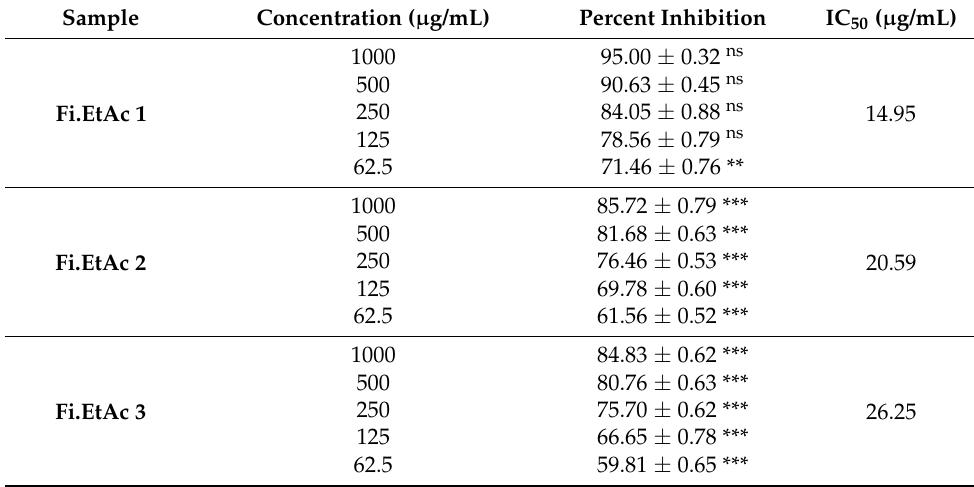
Table 4. DPPH results of semi-purified ethyl acetate fractions of Fragaria indica